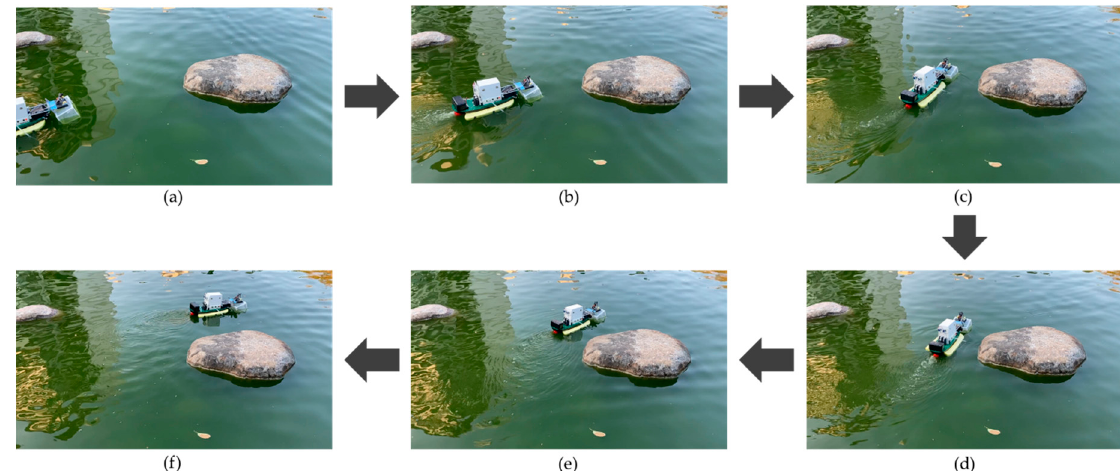
Figure 16. Experimental results for the obstacle avoidance task. ( a ) When ( D L > 65 cm) and ( D R > 65 cm), the MF-USV goes straight ahead. ( b ) When ( D L > 65 cm) and (10 cm < D R ≤ 65 cm), there is an obstacle on the right front side of the vehicle. ( c ) The MF-USV turns left. ( d ) The MF-USV keeps turning left. ( e ) When ( D L > 65 cm) and ( D R > 65 cm), the MF-USV goes straight ahead. ( f ) The MF-USV keeps going straight ahead.